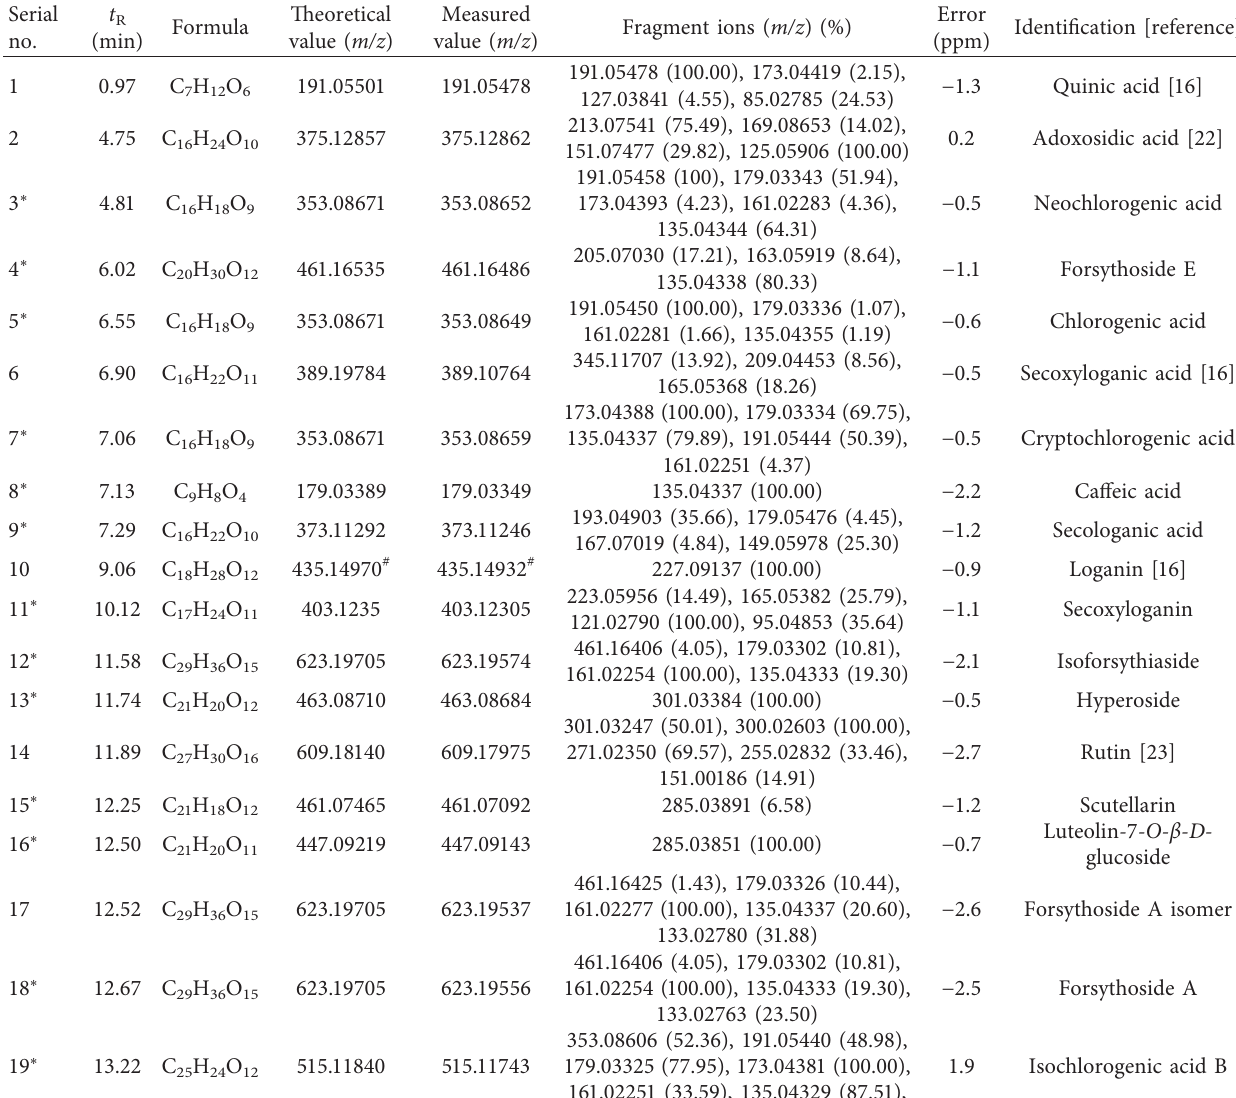
Figure 1: Total ion chromatograms of SHLI in positive ion mode (a) and negative ion mode (b). Table 1: Characterization of chemical constituents of SHLI by UHPLC/Q-Orbitrap-MS (negative ion